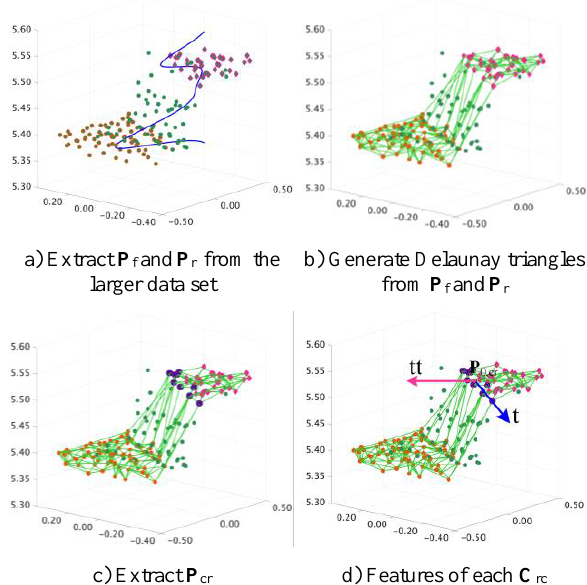
Figure 4. Extract points of a road edge and compute features of each C rc In reality, there are unreal-curb cells, for example the cells represent planter boxes along the footpath, along the road